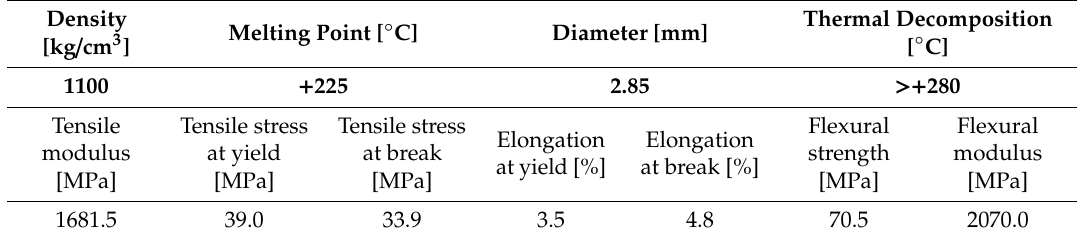
Table 2. Key properties of the ABS filament used in this study.